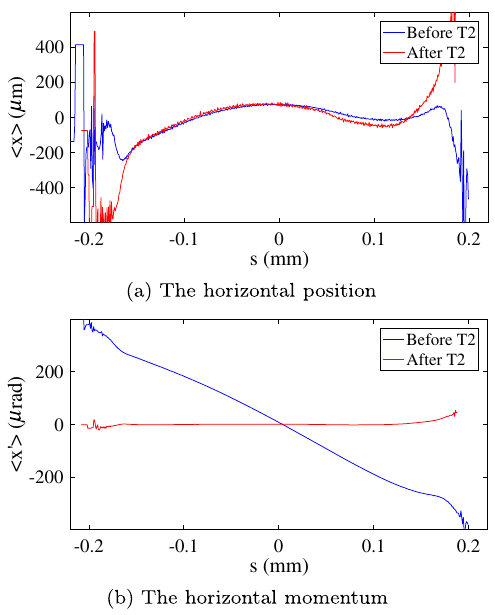
FIG. 5. The centroid of the horizontal distribution with respect to the longitudinal position before and after the second